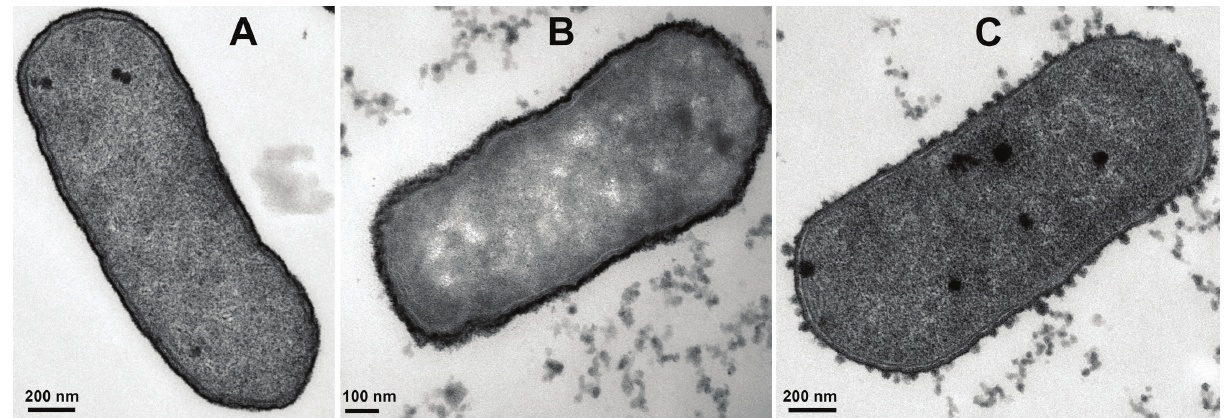
Figure 4. Sesquiterpenoid-mediated enhancement of PMX 50003 against E. coli ATCC 25922 via TEM. Panel A: control; Panel B: PMX 50003 (1× MIC), 15 min; Panel C: PMX 50003 (1× MIC) + 200 µM nerolidol, 5 min. Although PMX 50003 alone at 15 min exposure caused some damage to cells, the combination of nerolidol and PMX 50003 led to severe damage (blebbing) after only 5 min. These data provide evidence of cooperative interactions between nerolidol and this biomimetic